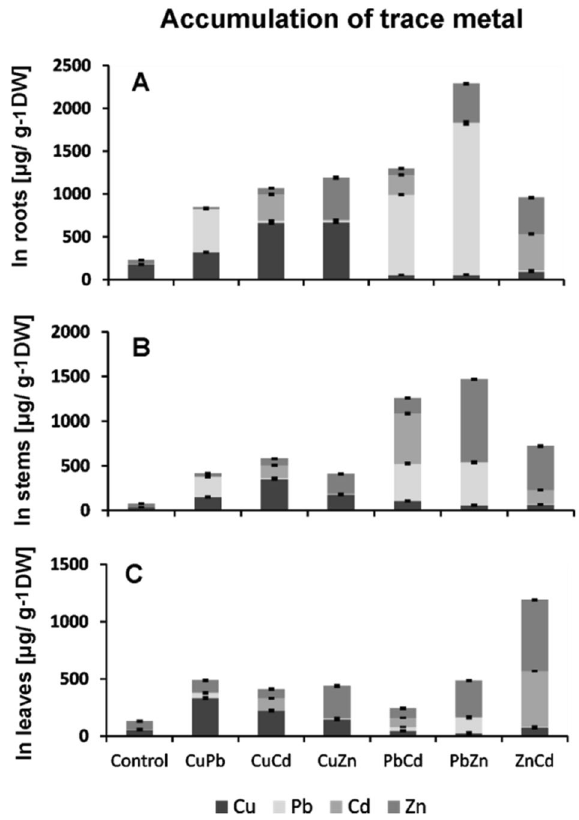
Figure 1. Accumulation of metals: Pb, Cu, Cd, and Zn in the roots ( A ), stems ( B ), and leaves ( C ) of B. juncea v. Malopolska seedlings. Plants were grown in Hoagland’s medium and treated metal bicombinations: CuPb, CuCd, CuZn, PbCd, PbZn, and ZnCd. Metal solutions Pb(NO 3 ) 2 , CuSO 4 , CdCl 2 , and ZnSO 4 were applied at a 25 μM concentration of each. Mean values of three replicates (±